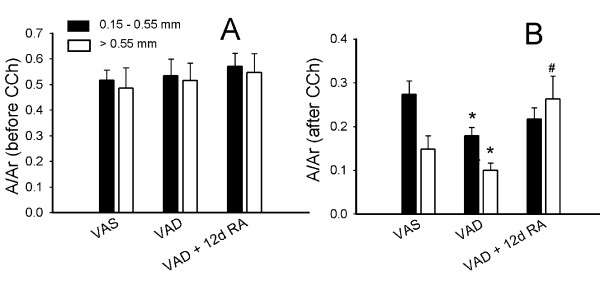
Airway contraction index is decreased in vitamin A deficient (VAD) rats. Airway contraction index (A/Ar, mean ± SEM, n = 9 rats for each retinoid treatment group). Solid bars are bronchi with diameters from 0.15 to 0.55 mm; open bars are bronchi with diameters greater than 0.55 mm. (A) shows that the contraction index prior to CCh-administration did not vary among the various retinoid treatment groups. After CCh-administration (B) the A/Ar was lower in VAD airways and was restored by retinoic acid (RA). (*) p < 0.05, VAD versus vitamin A sufficient (VAS). (#) p < 0.05, VAD + 12 days of RA versus VAD. Comparisons were between bronchi within the same range of diameters.